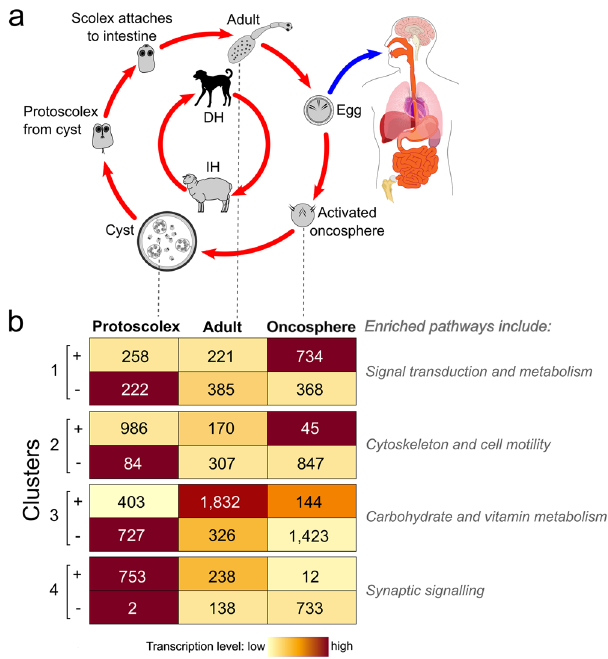
Fig. 3 Transcription in Echinococcus granulosus (genotype G1). a Life cycle of E. granulosus with key developmental stages indicated – adapted from ref. 23 – canid de fi nitive host (DH); intermediate host (IH). b Four distinct clusters (each with sub-clusters + and – ; divided according to fold-change (FC) ≥ 4 and FC ≤ − 4, respectively) of genes whose transcription correlated among the protoscolex, adult and oncosphere stages, inferred by weighted correlation network analysis (numbers in boxes are gene counts). The four Eg 95 genes (within sub-cluster 1 + ) are highly transcribed in the oncospheral stage. Enriched biological (KEGG) pathways representing individual gene clusters/sub-clusters are indicated. White lettering was used only to improve visibility of numbers on dark red